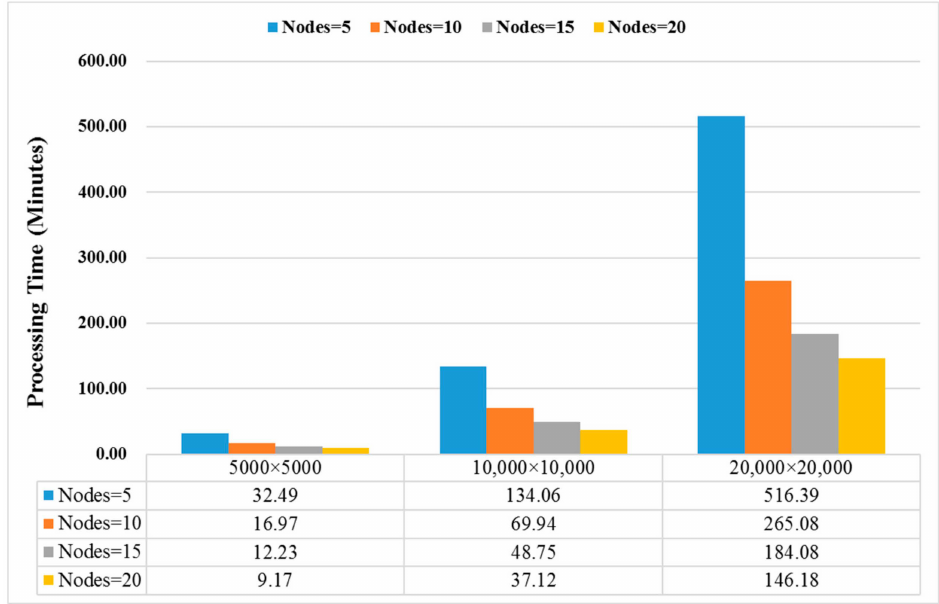
Figure 12. Processing time of PARSUC with di ff erent nodes and image